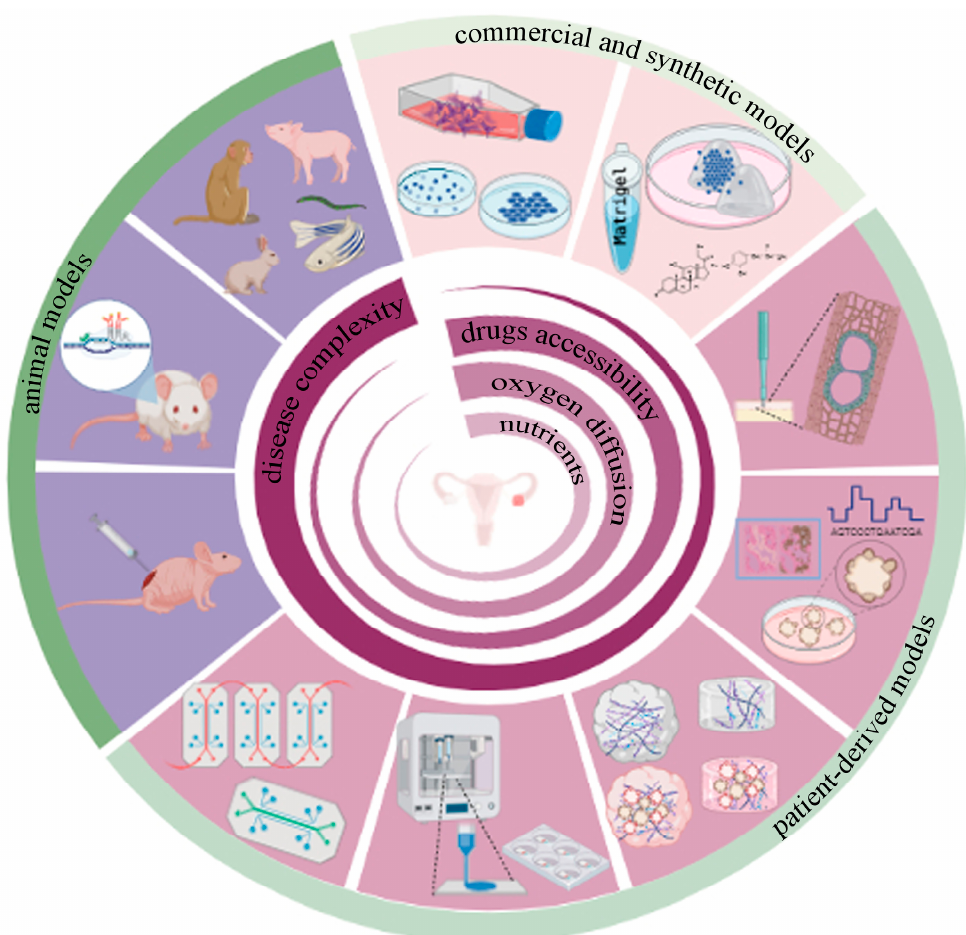
Figure 1. Preclinical models for epithelial ovarian cancer: clockwise, in light pink, commercial and synthetic preclinical models that include stabilized cells growing in conventional plastic plates, cell-derived spheroids, and synthetic hydrogels repopulated with cells or spheroids. The patient- derived preclinical model’s shown in dark pink represent ex-vivo tumor slices, PDOs, decellularized ECM (dECM) and hydrogel-derived, either dECM alone or repopulated with PDO, 3D bioprinting technology, and organ on a chip based on microfluidics technology, aiming to mimic not only ovarian tumors but also the metastatic sites. Purple denotes preclinical animal models including PDX, GEMM, and other animal species commonly used in scientific research, especially at the later stages of clinical